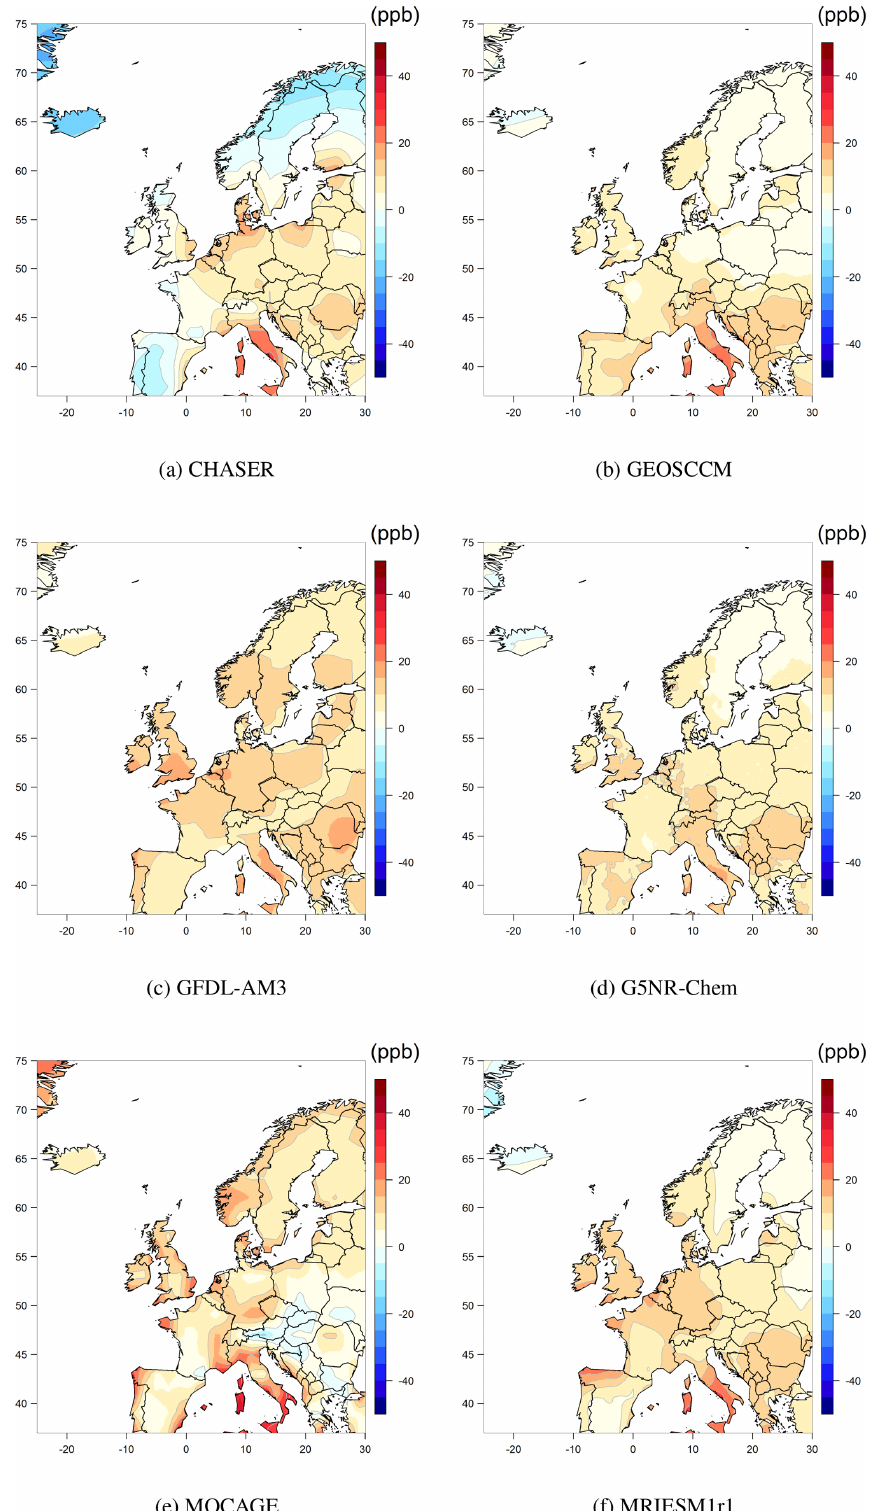
Figure 5. Spatial distributions of the ozone metric in Europe from each model minus spatially interpolated observations.